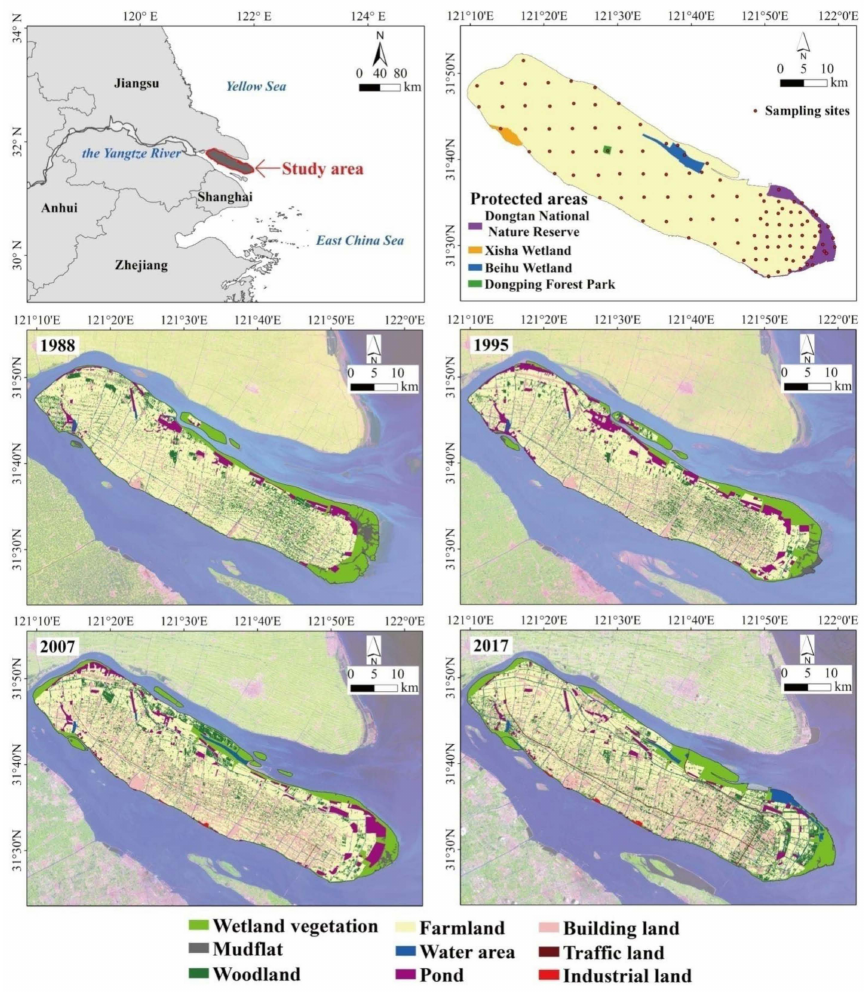
Figure 2. Location, sampling sites, island outlines, and land cover types of the study area: the sampling sites, island outlines, and land cover types were quoted from previous relevant studies by the authors [5,71]. The protected areas were sourced from the People’s Government of Chongming District in Shanghai